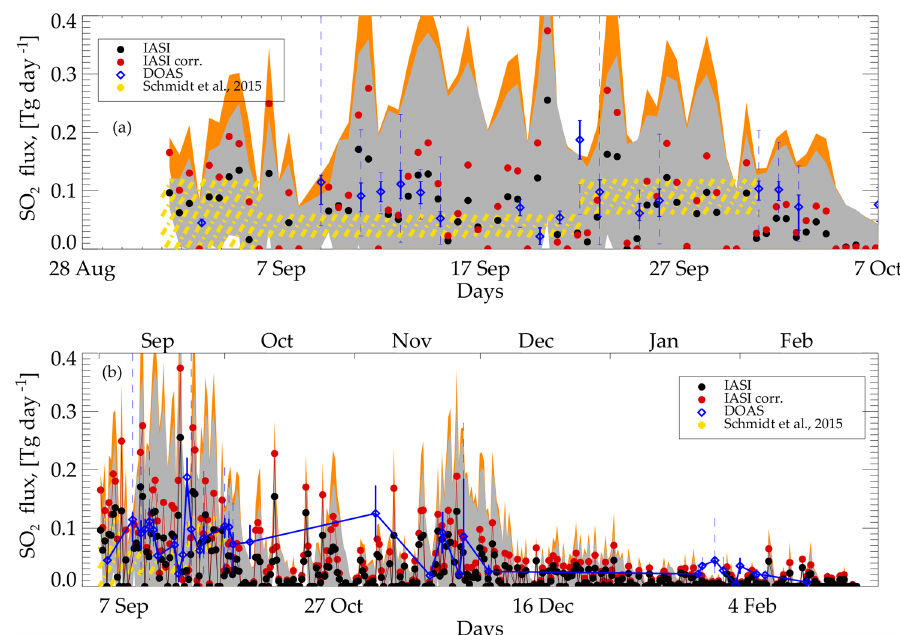
Figure 5. Time series of emission fluxes of SO 2 . To facilitate the comparison with the flux estimates from Schmidt et al. (2015), (a) presents values (for the first month only) of the retrieved SO 2 flux time series from IASI measured mass in black with grey error bars, the retrieved flux time series from corrected IASI mass in red with orange error bars and DOAS ground measurements from Pfeffer et al. (2018) in blue (blue bars show the errors, dotted bars show the maximum and minimum values measured that day). Panel (b) shows the 6-month time series with the same colour